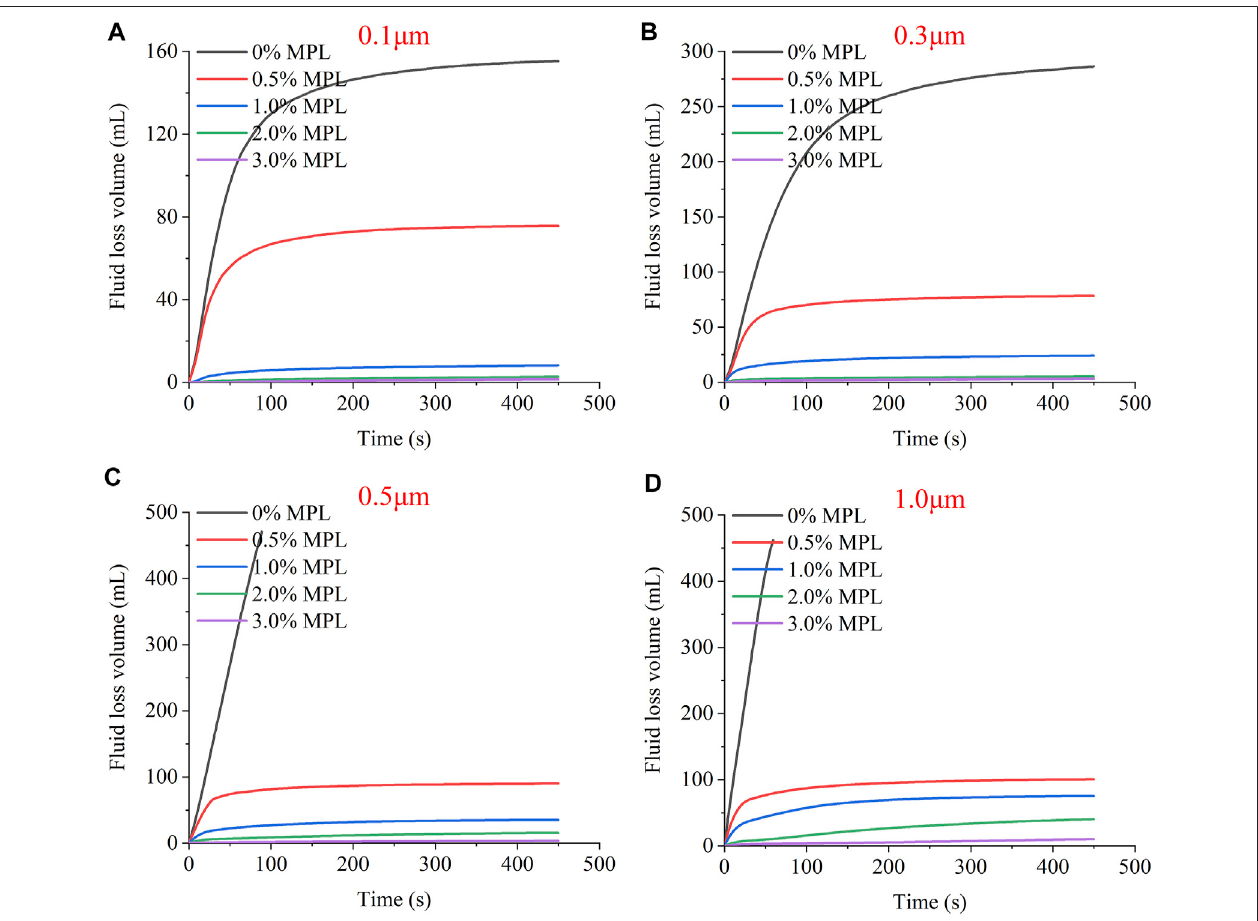
FIGURE 10 | The fl uid loss volume vs . time curves for MPL dispersions in emulsion for microporous membranes with different pore sizes: (A) 0.1 μ m, (B) 0.3 μ m, (C) 0.5 μ m, and (D) 1.0 μ m.